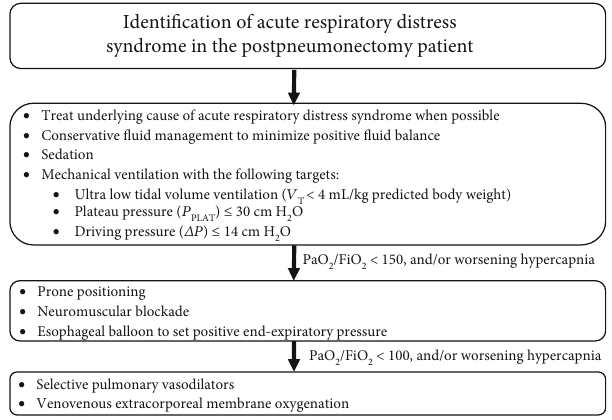
Figure 1: Chest radiograph on post-operative day #1.